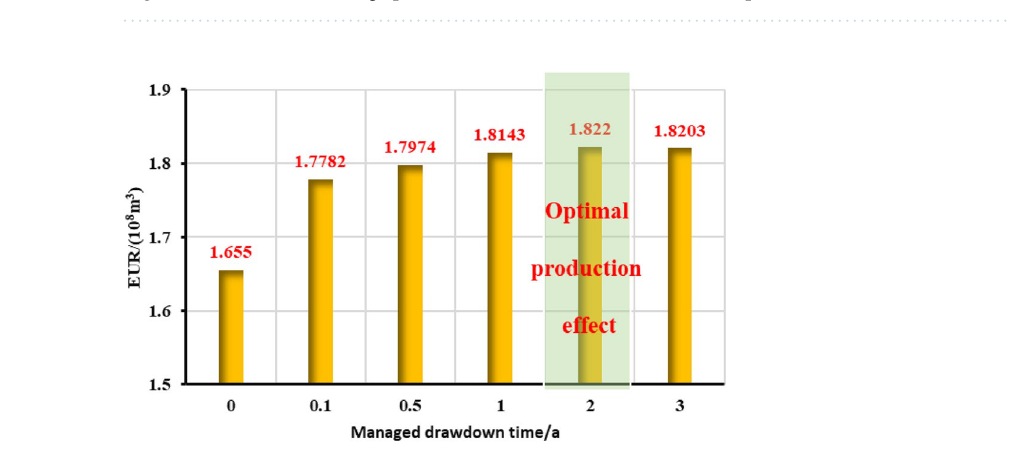
Figure 25. Reservoir average pressure and time chart under different pressure control durations.